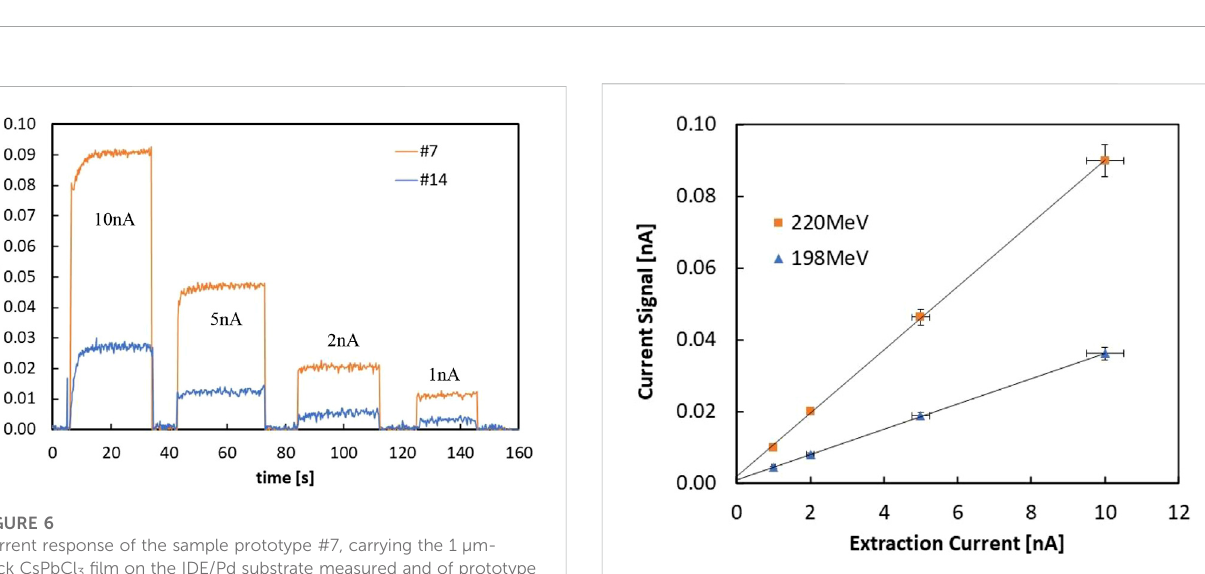
FIGURE 5 Current signal of the1 μ m-thick CsPbCl 3 fi lm deposited on the PdIDEs due to theexcitation ofatrain of square pulses from a365 nm UVLEDlamp with frequency of 1 Hz and intensity 100 W/m 2 . Measurements are carried out at different applied voltages and sampling time windows of 100 ms.